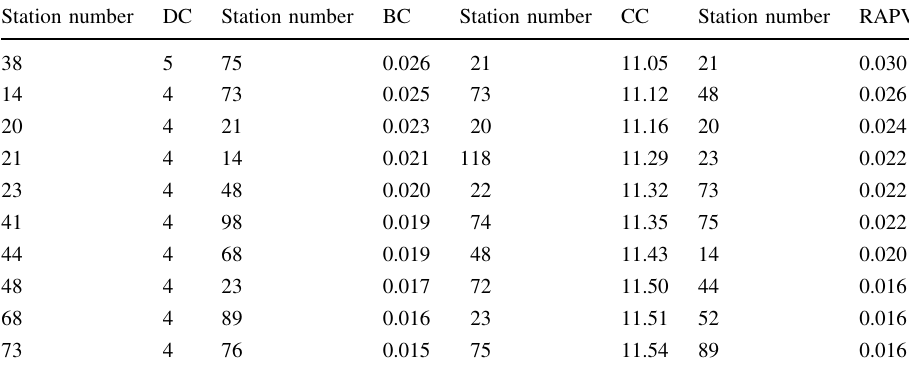
Table 4 The 10 most important stations identified by